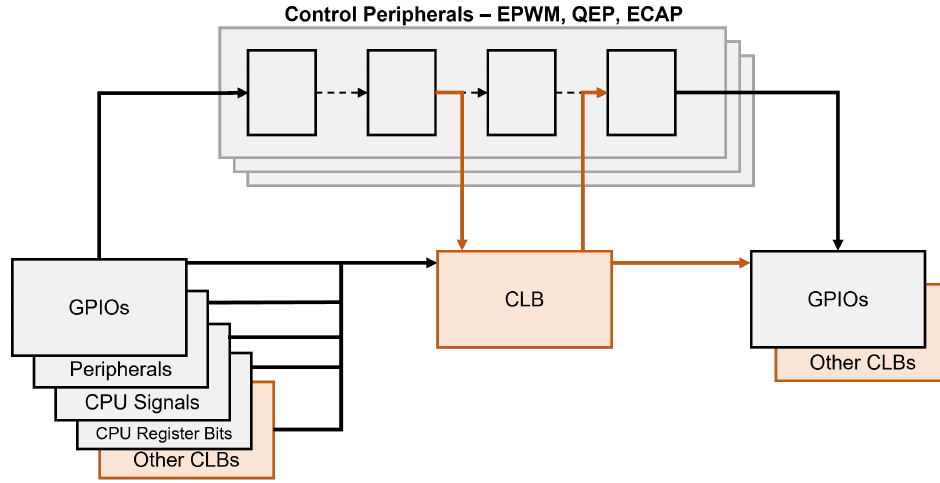
Figure 3. CLB operation inside and outside control